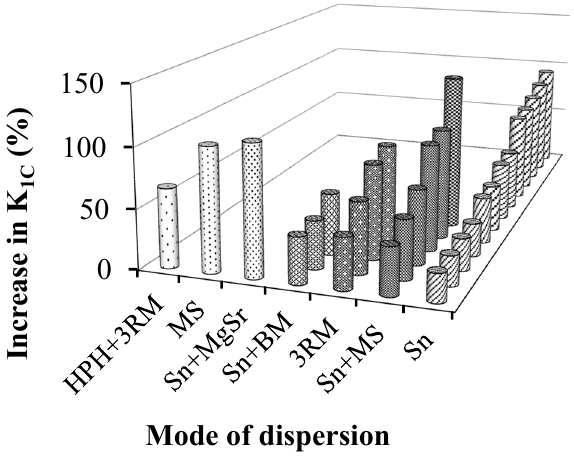
Figure 6. The maximum improvement in K 1C as a function of dispersion mode. (See references in Table 1).